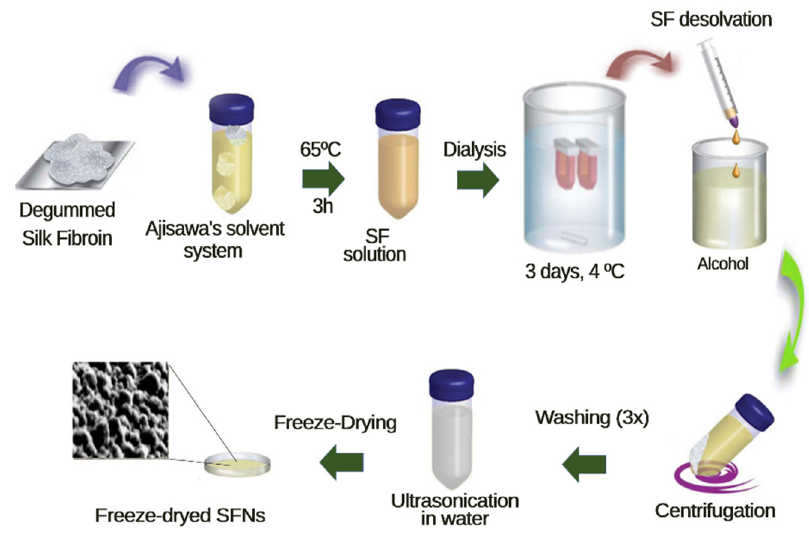
Figure 2. Schematic representation of the silk fibroin nanoparticles (SFN) preparation.